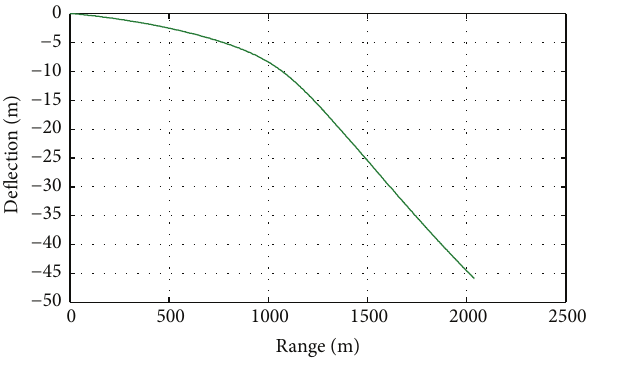
Figure 5: Trajectory deflection.